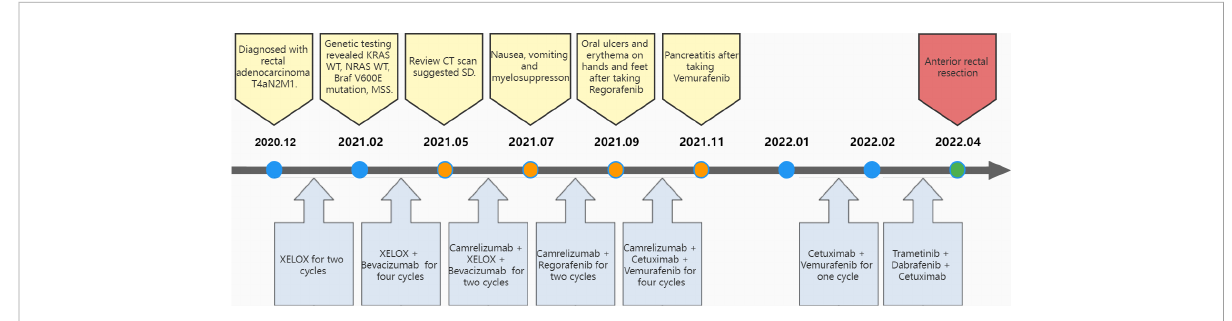
FIGURE 1 Flow of diagnosis and treatment. CT, computed tomography; SD, stable disease; XELOX, Capecitabine + Oxaliplatin